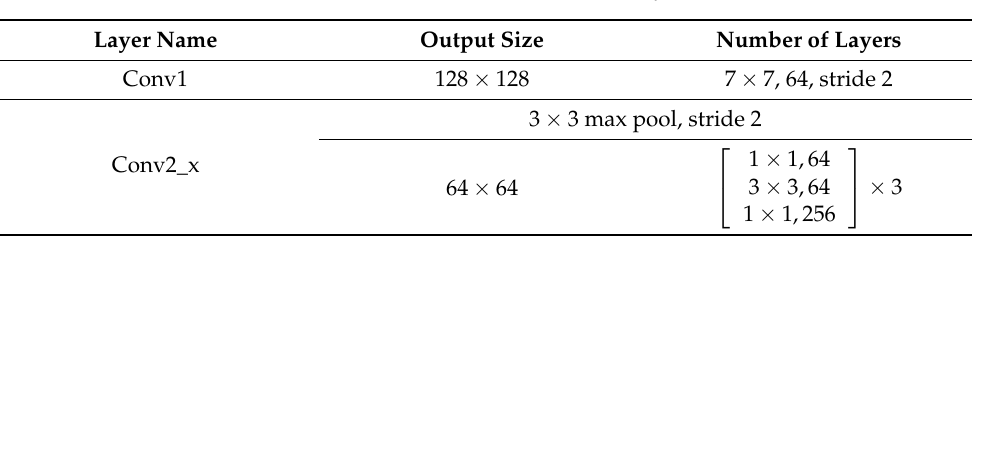
Figure 3. Sample synthetic data ( a ) DAS microseismic events contaminated with ambient noise from field data, ( b ) sample DAS ambient noise extracted from field data. Table 2. Dimensions and number of convolutional kernels in the 50-layer residual network